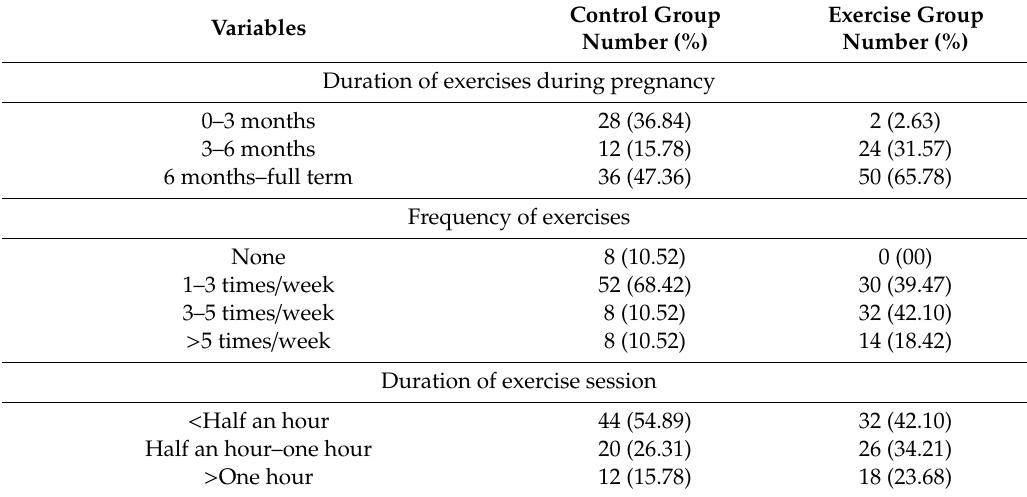
Table 3. Nature and duration of exercises in the control ( n = 76) and experimental ( n = 76) groups.